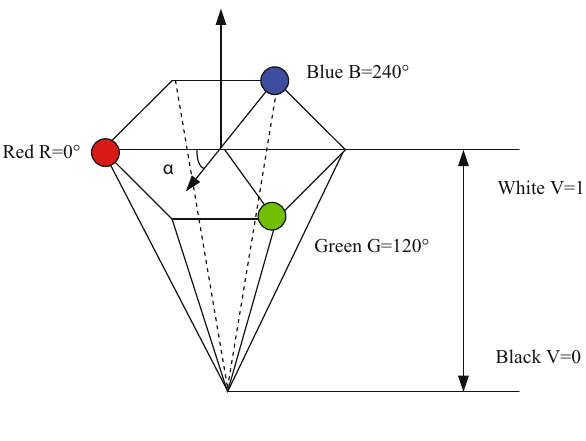
Figure 4: HSV color model.